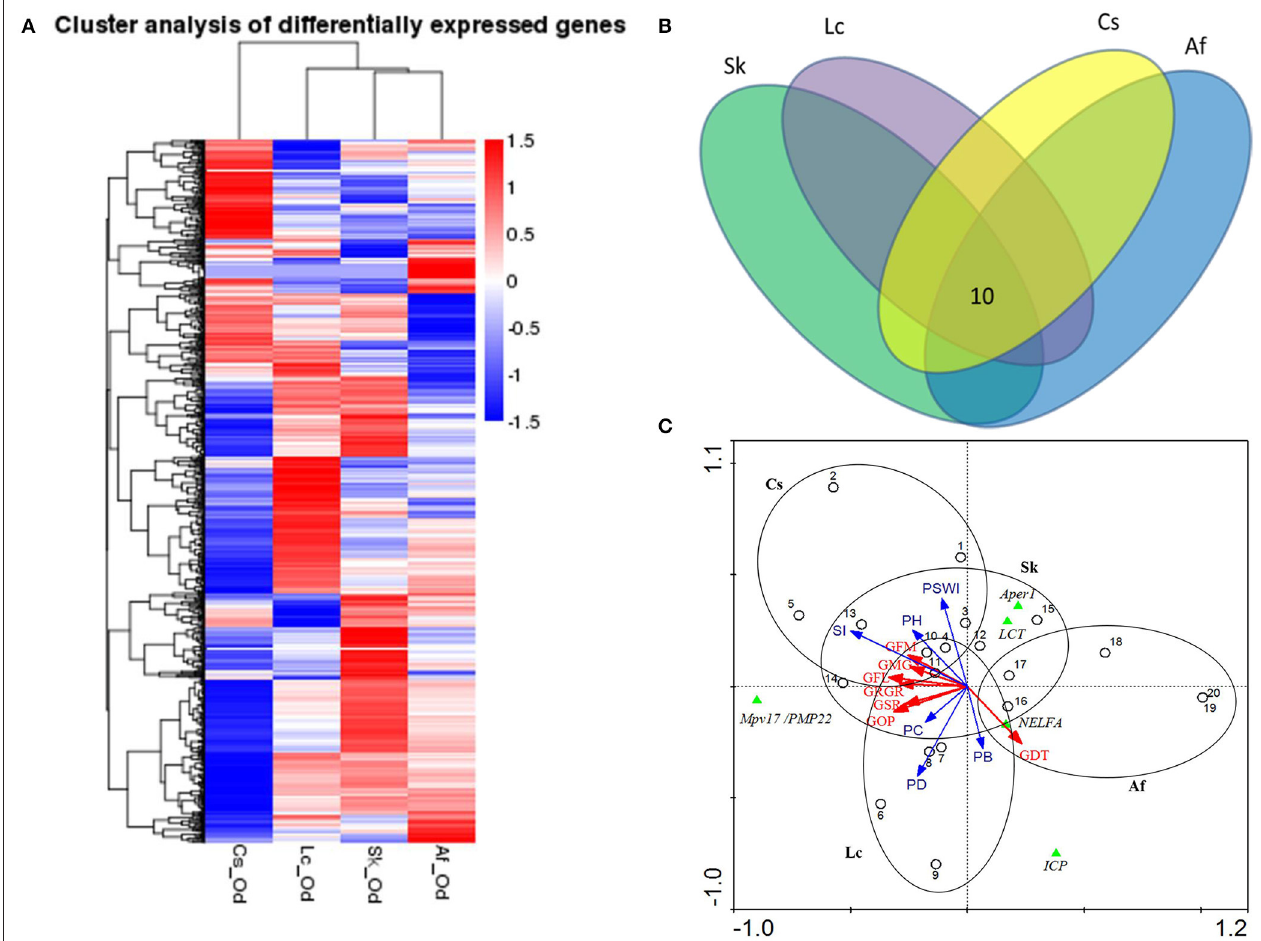
FIGURE 3 | (A) Cluster analysis of differentially expressed genes between different samples. The red color indicates the higher expressed genes, while the blue color indicates the lower expressed genes per treatment, and white indicates no difference. The value of the color indicates log 10 (FPKM + 1). All genes were at q < 0.005, |log2.Fold_change| > 1. (B) The common differentially expressed genes across four patches. Different ovals refer to different patches, where the number indicates the genes shared in all habitats. All genes were at q < 0.005, FPKM > 0.5, |log2.Fold_change| > 1. (C) The ordination triplot of grasshopper-genes-plant communities. Red arrows indicate grasshopper performance while blue arrows indicate plant community structure. Green triangles indicate the genes, dots indicate samples, and ellipses indicate the four patches, respectively. GFM, grasshopper female mass; GRGR, grasshopper relative growth rate; GMG, grasshoppers’ mass gain; GFL, grasshopper female length; GDT, grasshopper development time; GSR, grasshopper survival rate; GOP, grasshopper overall performance; PSWI, plant Shannon-Wiener index; SI, plant selective index; PH, plant height; PD, plant density; PB, plant biomass; PC, plant coverage; Aper1, peritrophin-1; Mpv17/PMP22, the 22 kDa peroxisomal membrane protein; ICP, insect cuticle protein; NELFA, negative elongation factor A; LCT, lactase-phlorizin